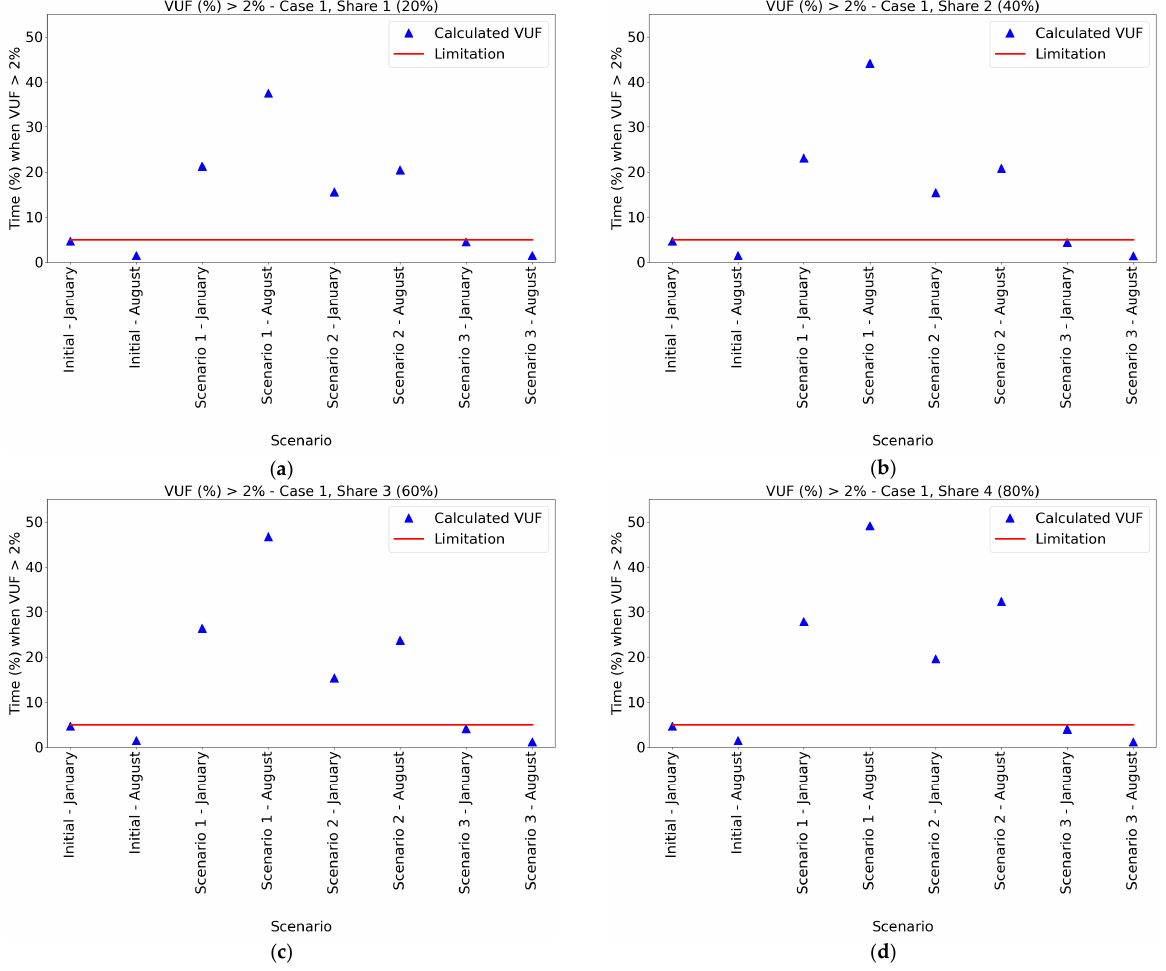
Figure 3. VUF > 2%—Case 1; Share 1–Share 4; January, August.